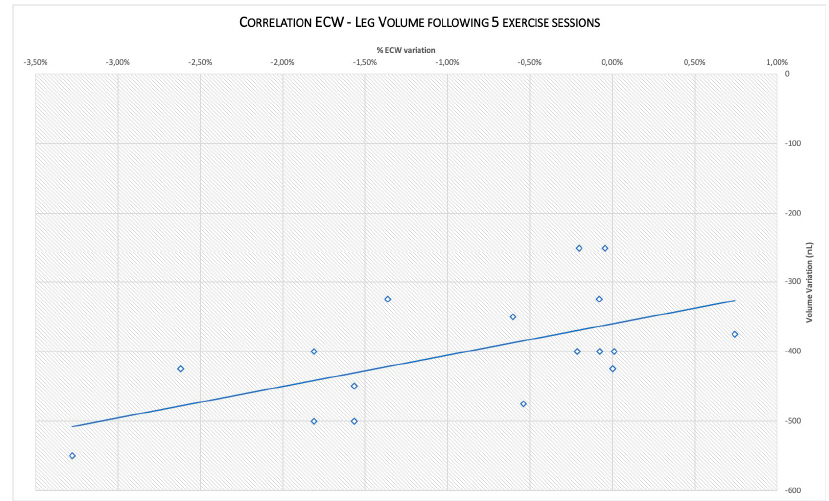
Figure 4. Correlation between leg volume and % ECW variation from baseline (T0) to the end of the exercise program (T14).